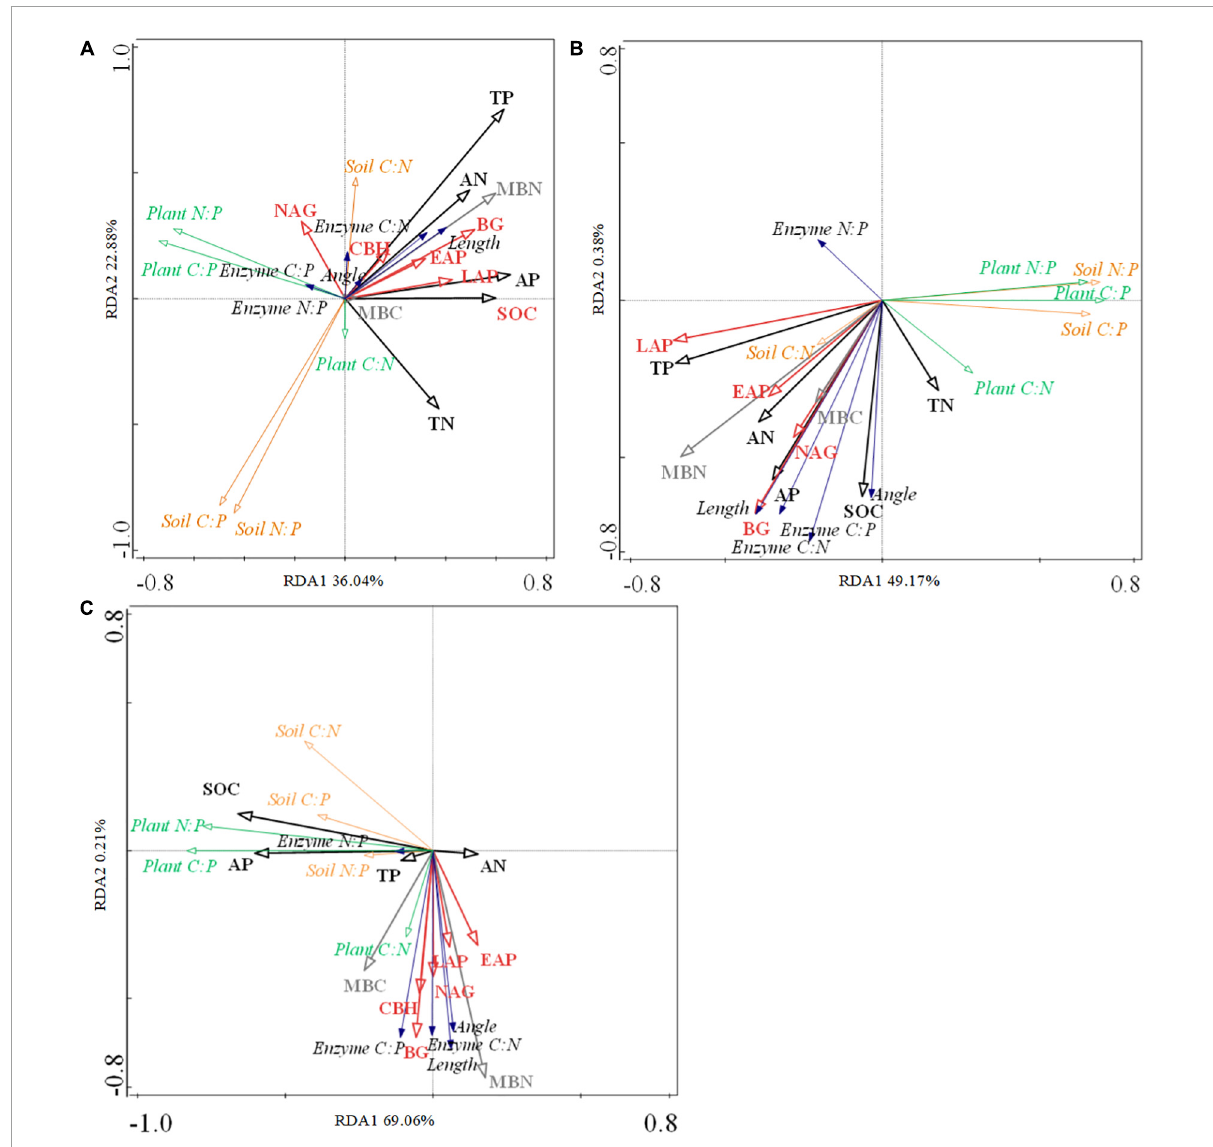
FIGURE5 Relationships between soil nutrients (black), soil microbial biomass (gray), and soil enzyme activity (red) and plant (green)—soil (pink) -enzyme (blue) C-N-P stoichiometry in early- (A) , mid- (B) , and late-species (C) . SOC, soil organic carbon. TN, soil total nitrogen. TP, soil total phosphorus. AN, soil available nitrogen. AP, soil available phosphorus. MBN, soil microbial biomass nitrogen. MBC, soil microbial biomass carbon. BG, β -1,4-glucosidase. NAG, β -1,4-N-Acetylglucosaminidase. CBH, β -D-Cellobiosidase. MAP, Acid phosphatase. LAP, L-Leucine aminopeptidase.